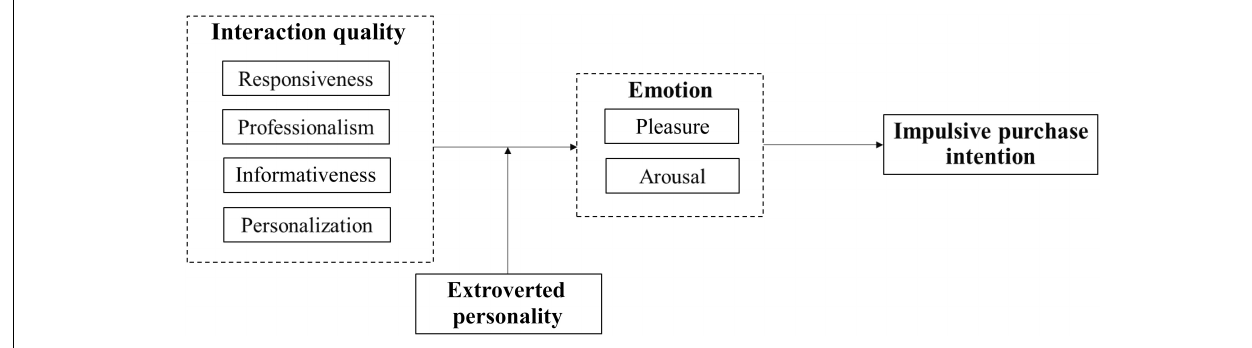
FIGURE 1 | Interaction